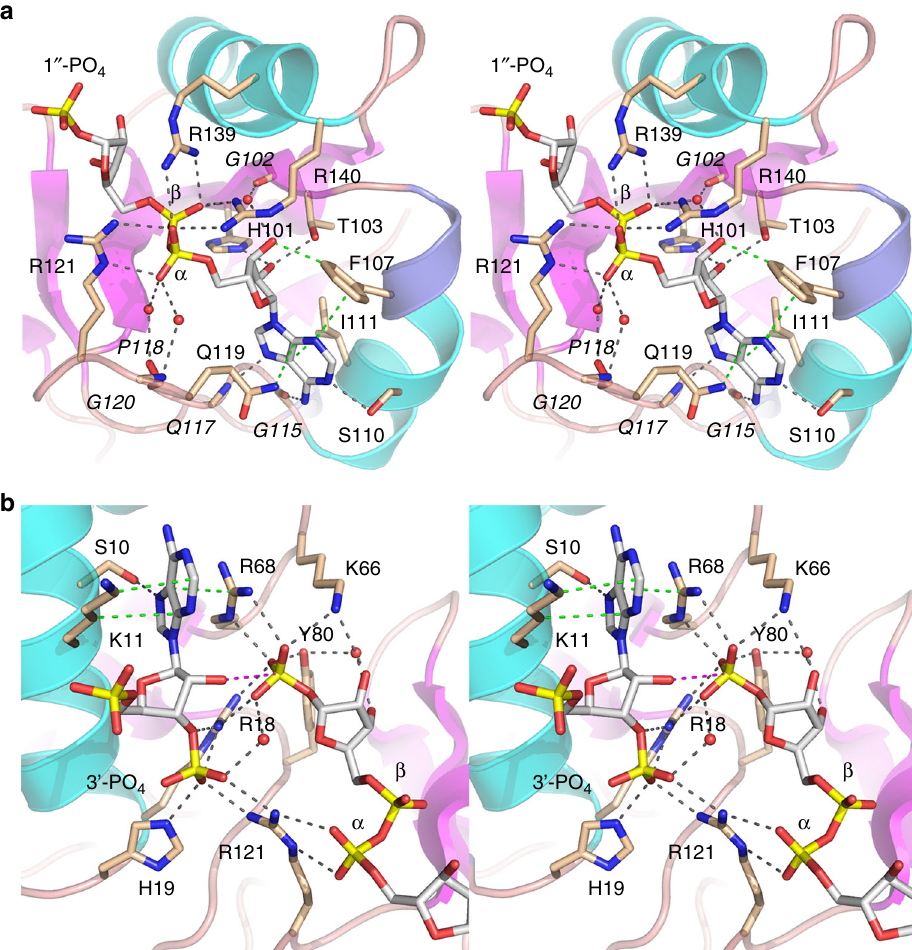
Fig. 3 Tpt1 active site. Stereo views of the atomic interactions of Tpt1 with the ADP-ribose moiety of the ADP-ribose-1 ″ -PO 4 product a and the pAp and 1 ″ - PO 4 moieties b . Selected Tpt1 amino acids are depicted as stick models with beige carbons. The ligands are depicted as stick models with gray carbons. Waters are depicted as red spheres. Hydrogen bonds are denoted by black dashed lines and van der Waals contacts by green dashed lines. The distance (3.5 Å) from the ribose 2 ′ -O to the 1 ″ -P in b is indicated by a magenta dashed line. Amino acids that make side-chain contacts to the ligand are labeled in plain font; those that make main-chain contacts to the ligands are labeled in